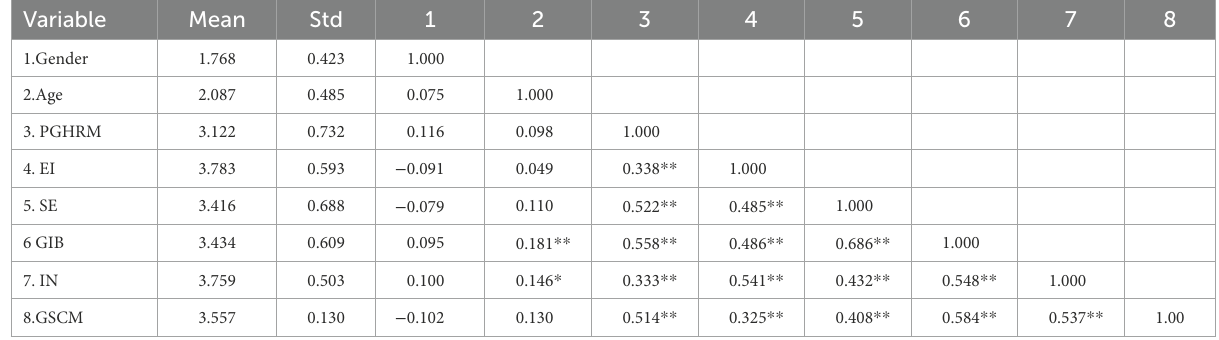
TABLE 3 Mean, standard deviation, and correlation coefficient.